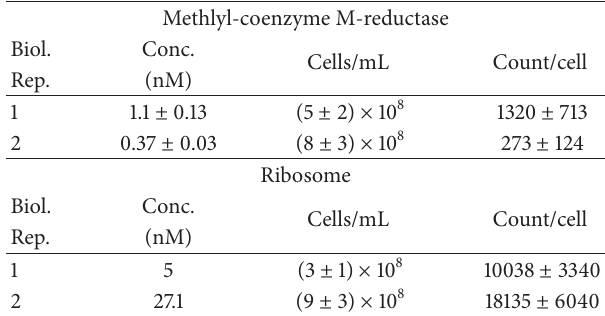
Table 3: Mean protein copy numbers per cell for Mcr complex and ribosomes as estimated by dividing concentration of McrG and Rpl18p subunits in cell lysates by number of cells in the culture. All experiments were done with three technical replicates and two biological replicates grown in